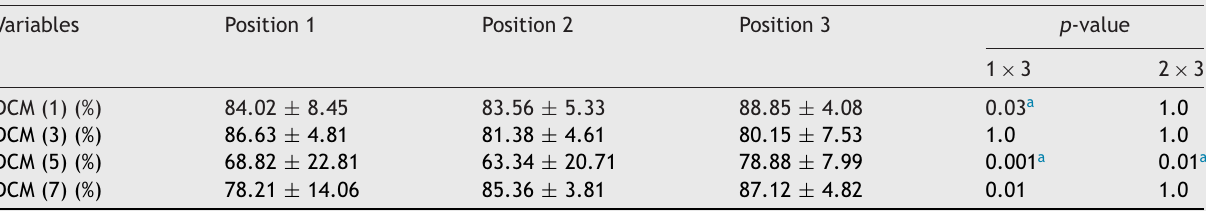
Mean and standard deviation of the variable directional control of movement (DCM) of the stability limit, as a